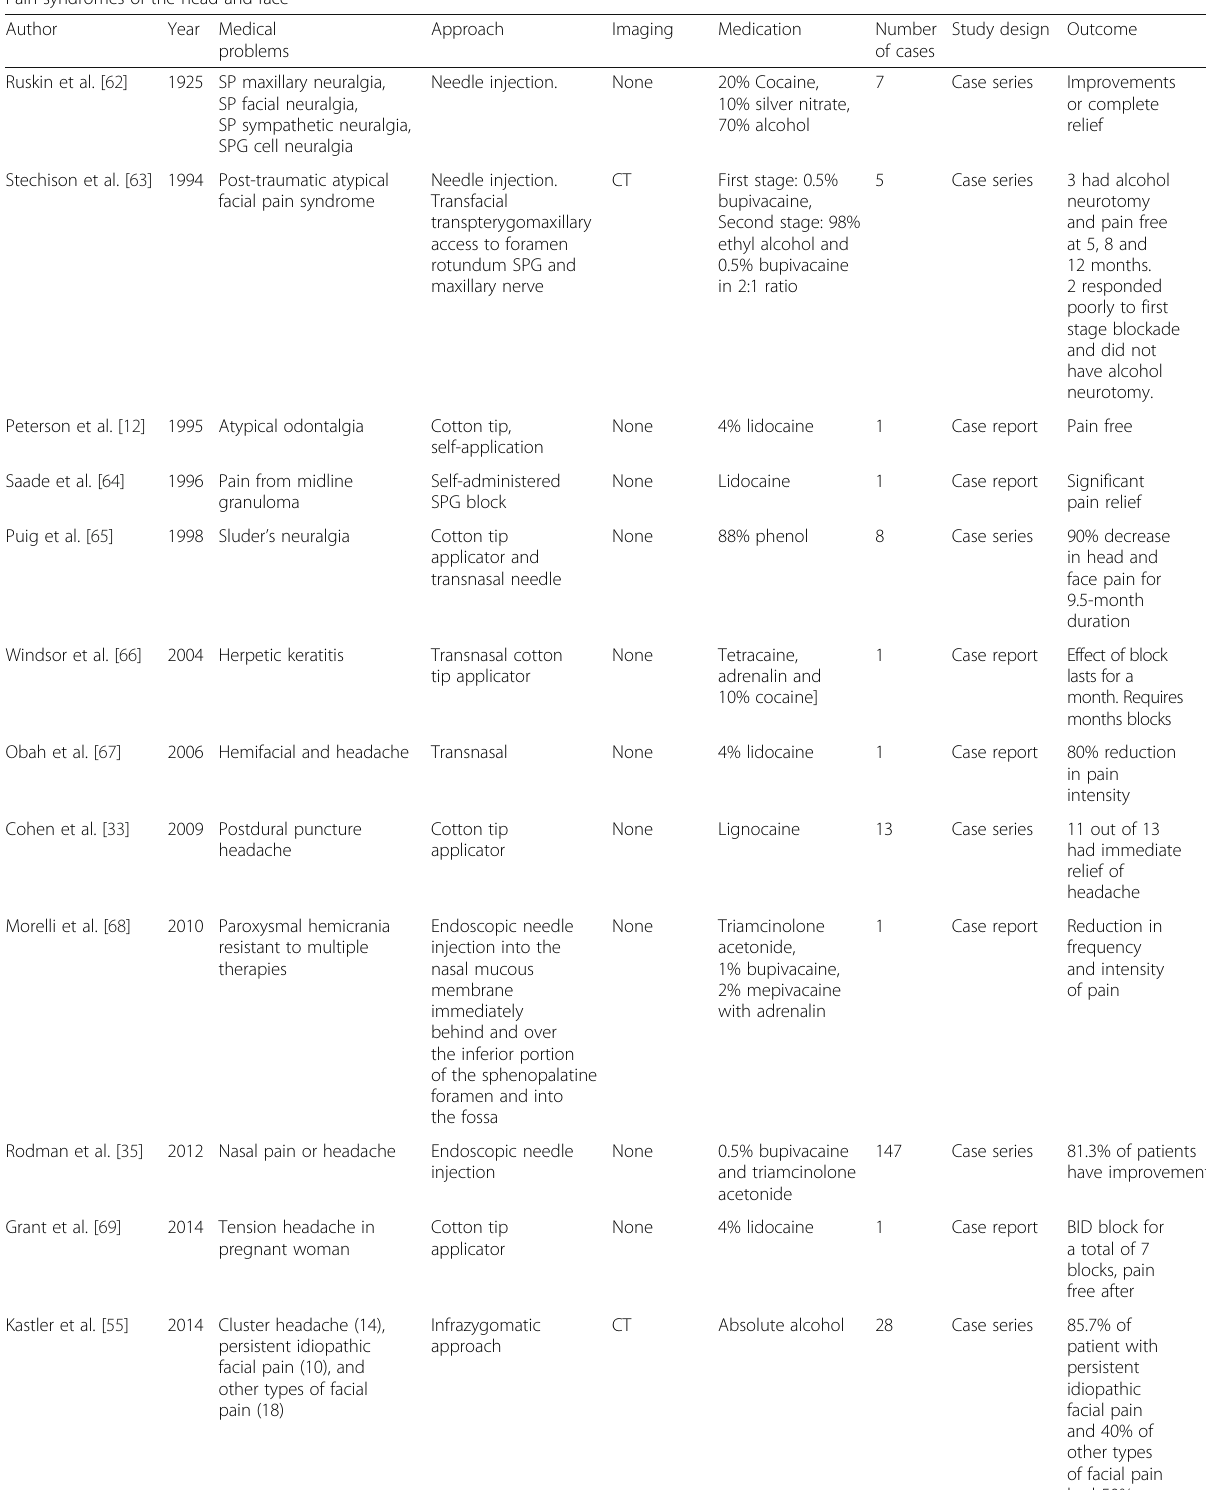
Table 11 Studies of SPG blocks for other pain syndromes of the head and face Pain syndromes of the head and